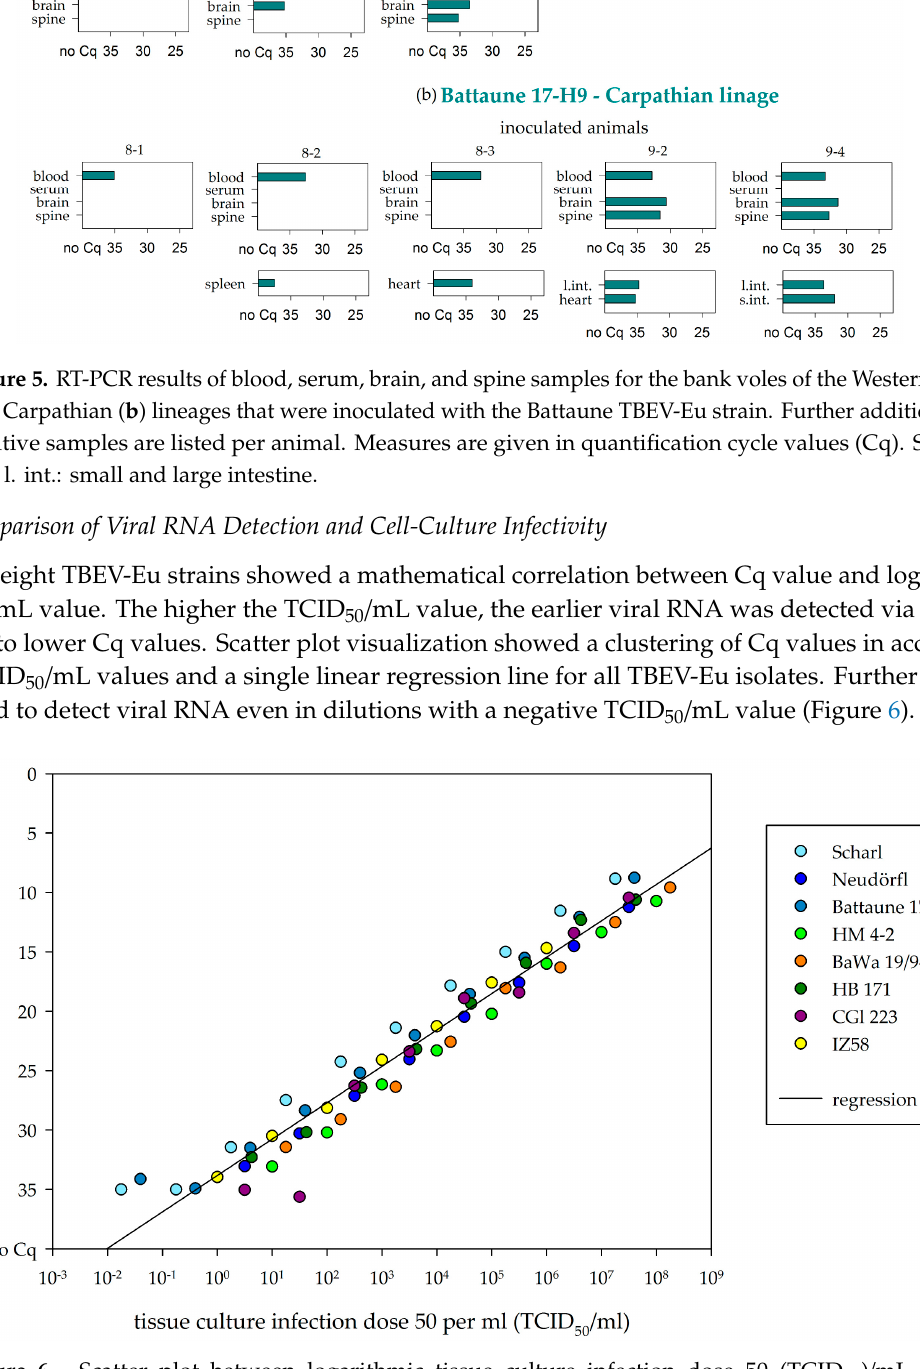
Figure 6. Scatter plot between logarithmic tissue culture infection dose 50 (TCID 50 ) / mL and quantification cycle values (Cq) of TBEV-Eu isolates. Dots are color marked in accordance to each TBEV-Eu isolate. Regression line is drawn for the mean of all